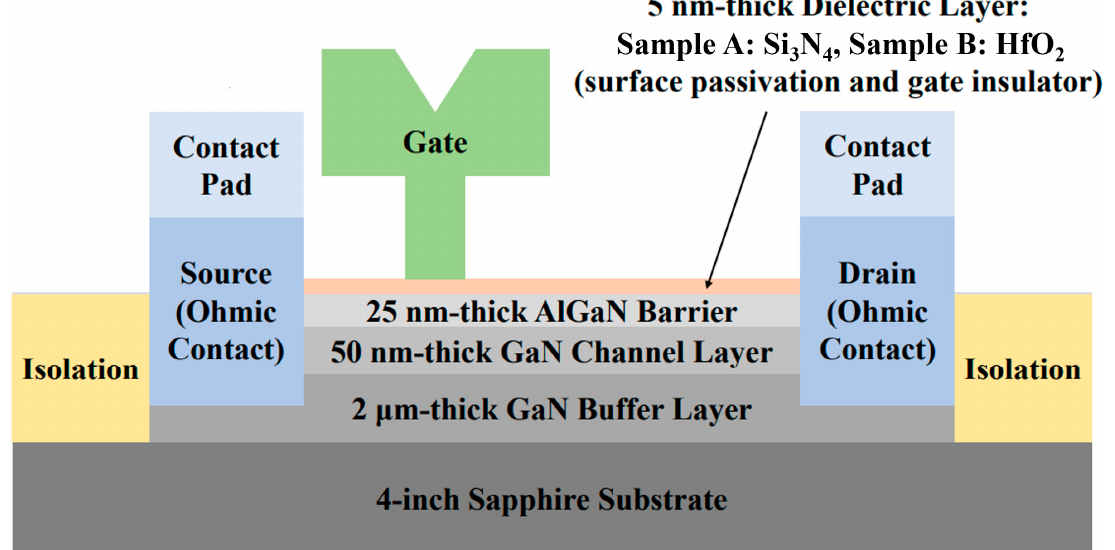
Figure 1. Schematic cross-section of the processed GaN-based MIS-HEMTs for the 5 nm-thick Si 3 N 4 and HfO 2 gate insulator. The 5 nm-thick Si 3 N 4 and the HfO 2 layer were employed for Sample-Si 3 N 4 and Sample-HfO 2 , respectively, which acted as the gate insulator and surface passivation.